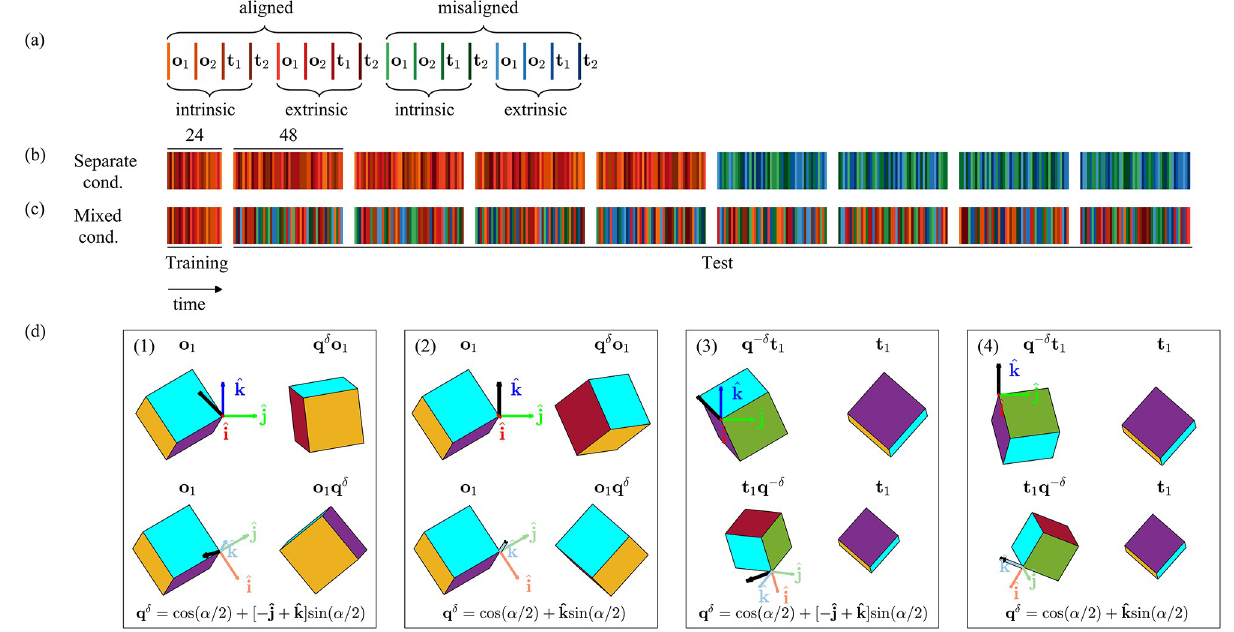
Fig 2. Experimental design and participants groups—experiment 1. The experiment consisted of two sessions: Training (24 trials) and Test (48 × 8 trials). In the Training session, all targets were presented by rotating the initial cursor orientation around an axis that was aligned to either an intrinsic or an extrinsic reference frame. The Test session of the Separate cond. group contained four trial sets with aligned axes followed by four trial sets with misaligned axes. The Test session of the Mixed cond. group contained eight trial sets with mixed aligned and misaligned axes. In both groups, half of the trials initiated from two fixed initial hand orientations ( o 1 and o 2 2 H ), while the rest had two fixed target orientations ( t 1 and t 2 2 H ). (a) Legend for 1 1 the different experimental conditions of each trial. (b) The order of the trials in the Separate cond. group. (c) The order of the trials in the Mixed cond. group. (d) Examples of trials from the experiment. In each box, the left column shows the initial cursor orientation and the right column shows the respective target orientation (the notations of the initial cursor and target orientations, and the transition quaternion are in the inset; see Table 1 for more details). α is the rotation angle, and q − δ is the inverse of the transition quaternion. The top row shows trials constructed using rotation axes that are either misaligned (box 1 and 3) or aligned (box 2 and 4) with an extrinsic reference frame (dark red, green, and blue arrows). The bottom row shows trials constructed using rotation axes that are either misaligned (box 1 and 3) or aligned (box 2 and 4) with an intrinsic reference frame (light red, green, and blue